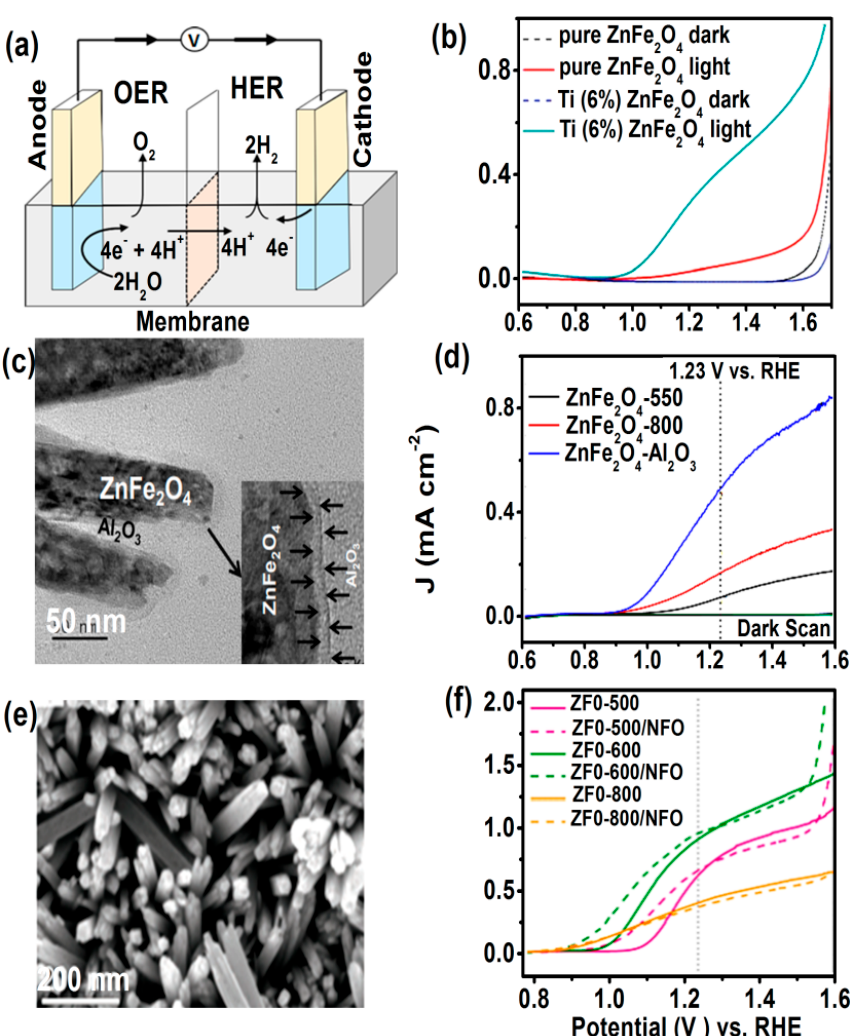
Figure 15. ( a ) Schematic of electrolysis cell for water splitting, ( b ) current density J vs. potential curves, V of ZnFe 2 O 4 photoanodes (Reproduced with permission from [92]. Copyright Royal Society of Chemistry, 2017). ( c , d ) TEM image of ZnFe 2 O 4 -Al 2 O 3 and corresponding J vs. V curves (Reproduced with permission from [93]. Copyright Royal Society of Chemistry, 2018). ( e ) SEM images ZnFe 2 O 4 nanorod, ZFO-500 ( f ) J vs. V curves (Reproduced with permission from [95]. Copyright Wiley, 2018).